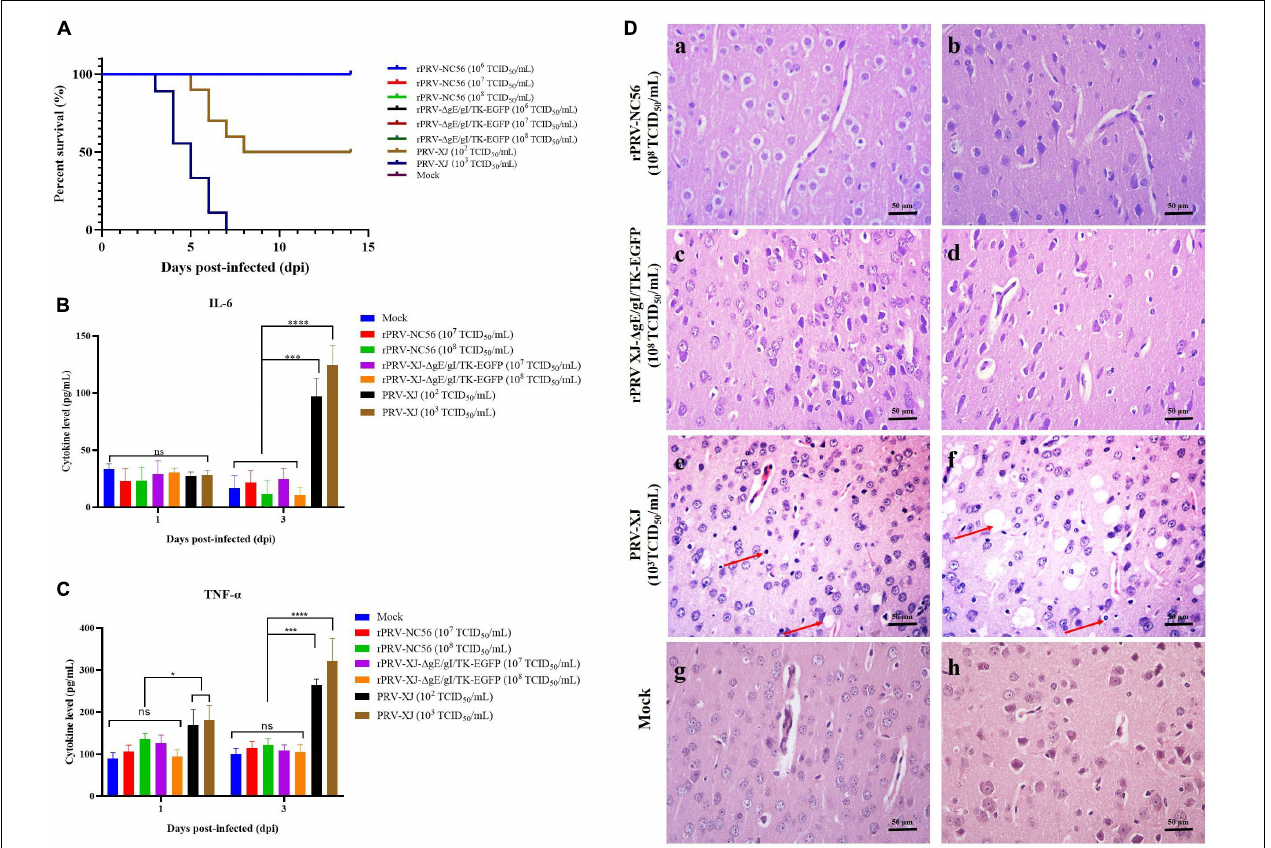
FIGURE 5 | The safety assessment of rPRV-NC56. (A) Survival rate of mice infected with different titers of PRV XJ, rPRV XJ- (cid:49) gE/gI/TK-EGFP, and rPRV-NC56. (B) Plasma IL-6 was detected by enzyme-linked immunosorbent assay (ELISA). (C) Plasma TNF- α was detected by ELISA. (D) Pathological observation of HE staining in brain tissue of mice infected with PRV XJ, rPRV XJ- (cid:49) gE/gI/TK-EGFP, and rPRV-NC56 ( × 400). a, c, and e were granulocyte layers in the cerebral cortex, and b, d, and f were the pyramidal cell layers in the cerebral cortex. ∗ p < 0.05; ∗∗ p < 0.01; ∗∗∗ p < 0.005; and ∗∗∗∗ p < 0.001. Neuronal necrosis and vacuolar degeneration are indicated by red